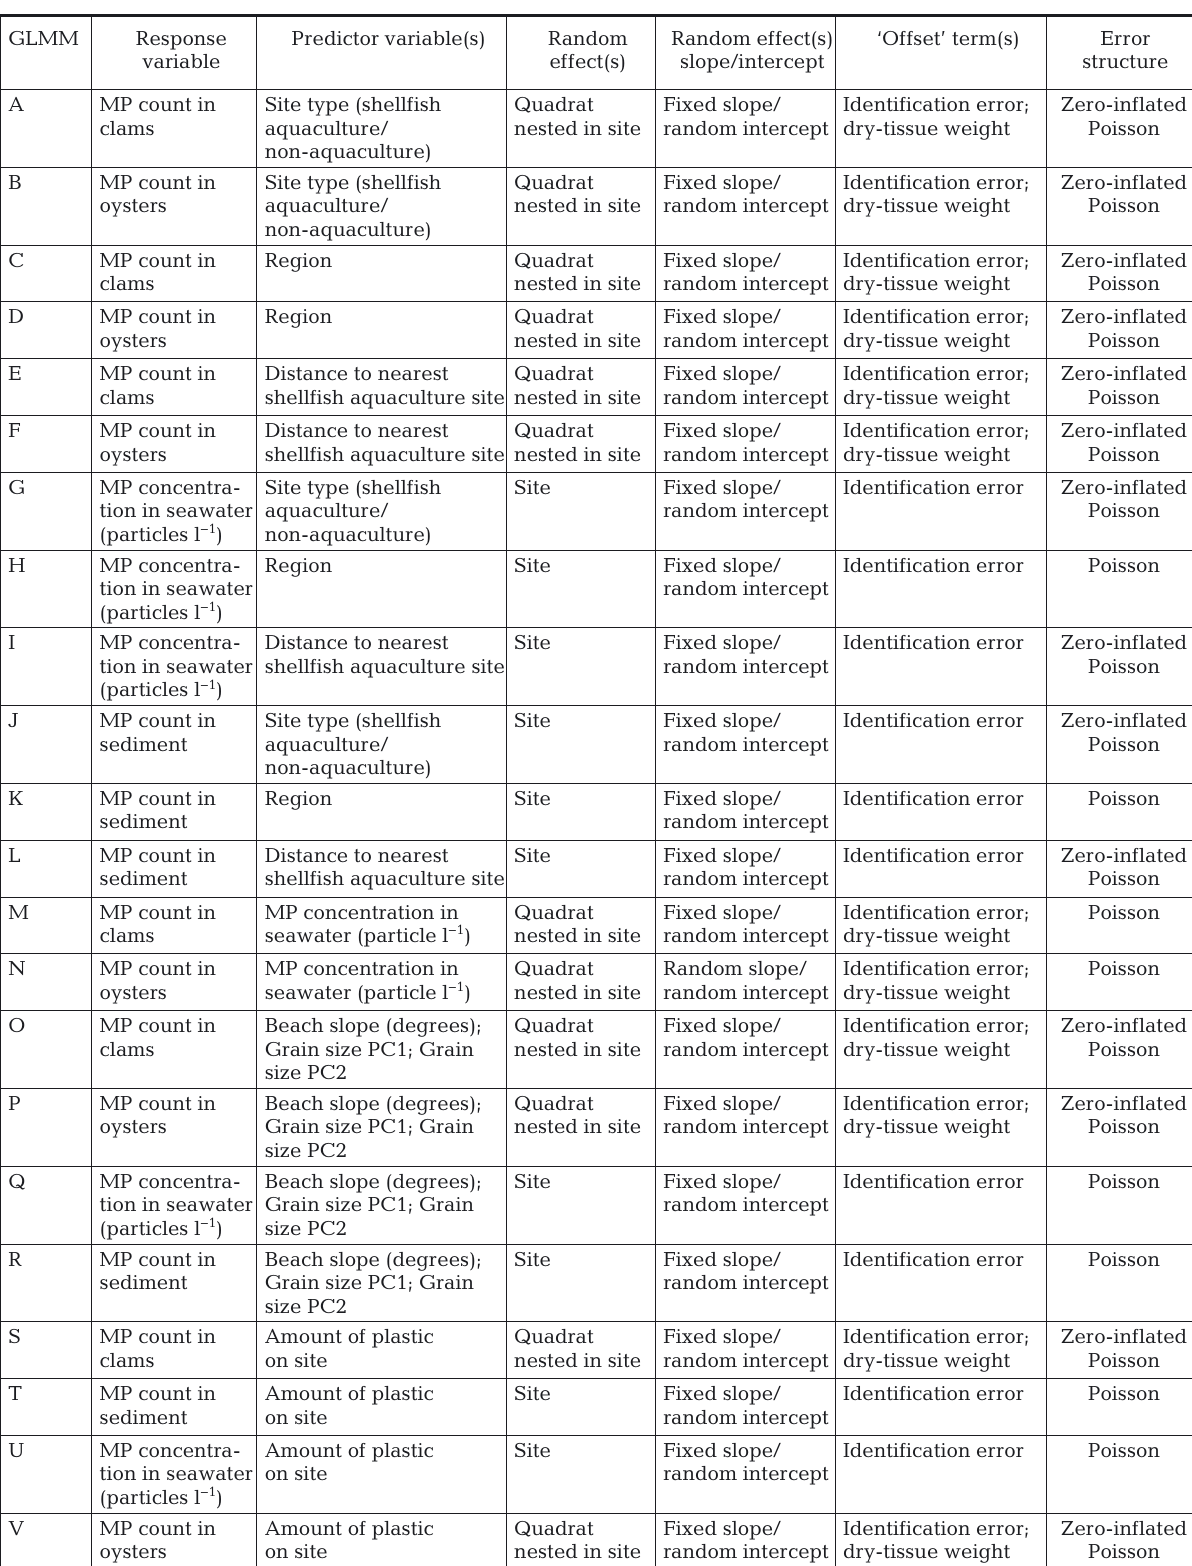
Table 2. Generalized linear mixed models (GLMMs) and the response and predictor variables, random effects and whether their slopes and intercepts were assumed to be random or fixed, ‘offset’ terms specified in R, and the assumed error structure. These models were used in the statistical analyses of variables relating to microplastic particle (MP) concentrations in clams, oysters, seawater, and sediment